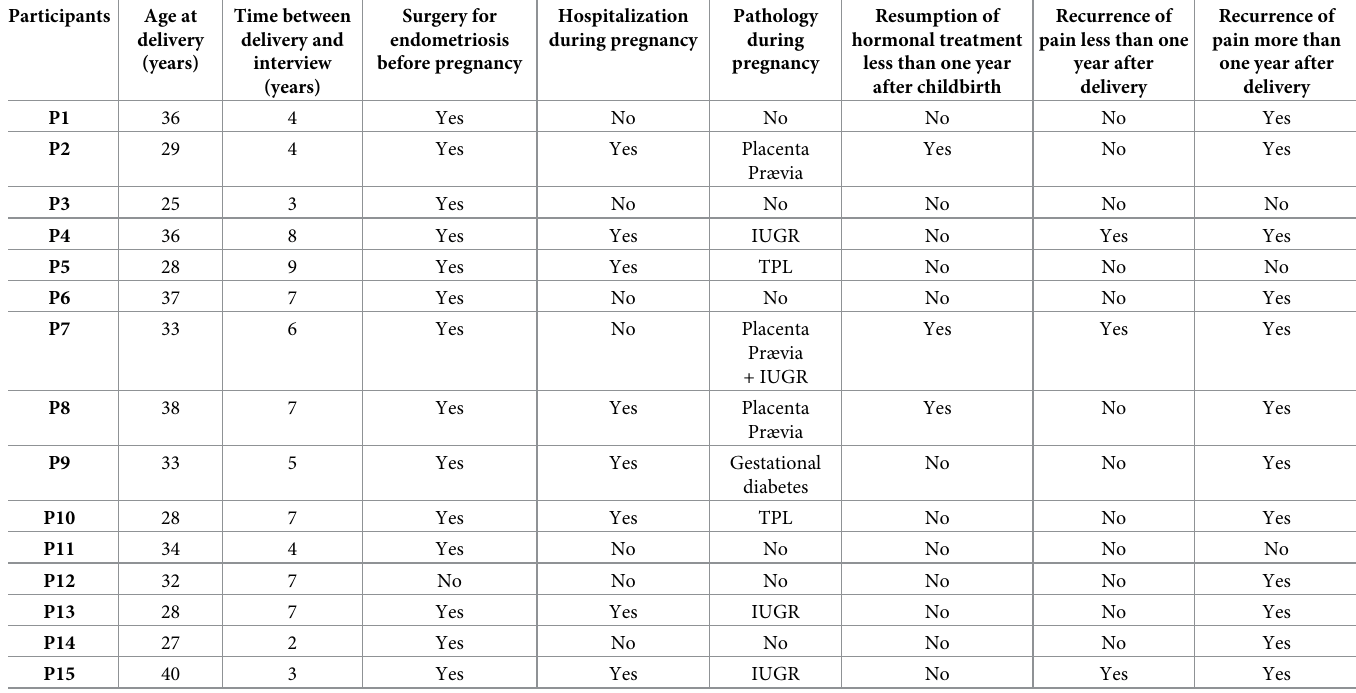
Table 1. Main characteristics of the